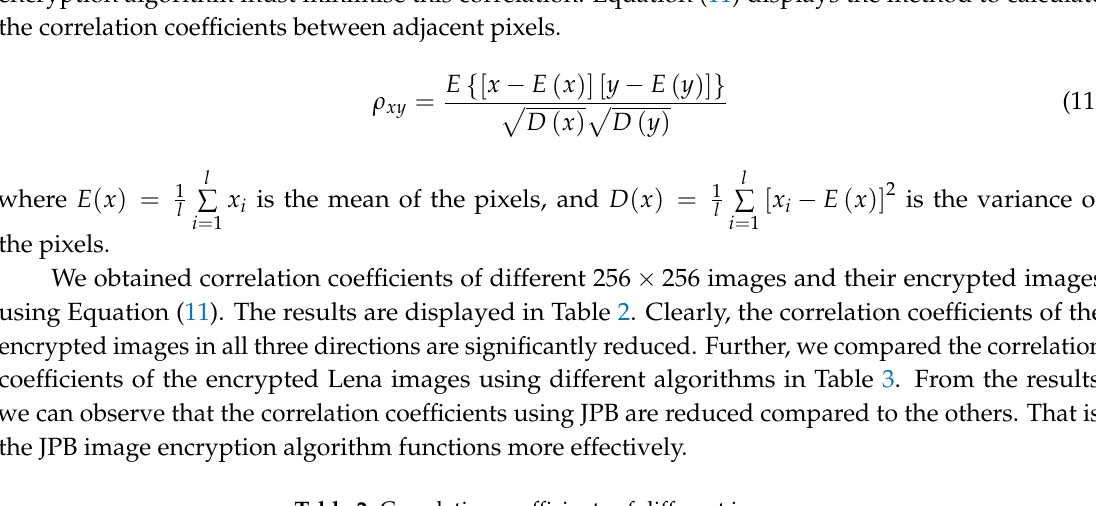
Table 2. Correlation coefficients of different images.